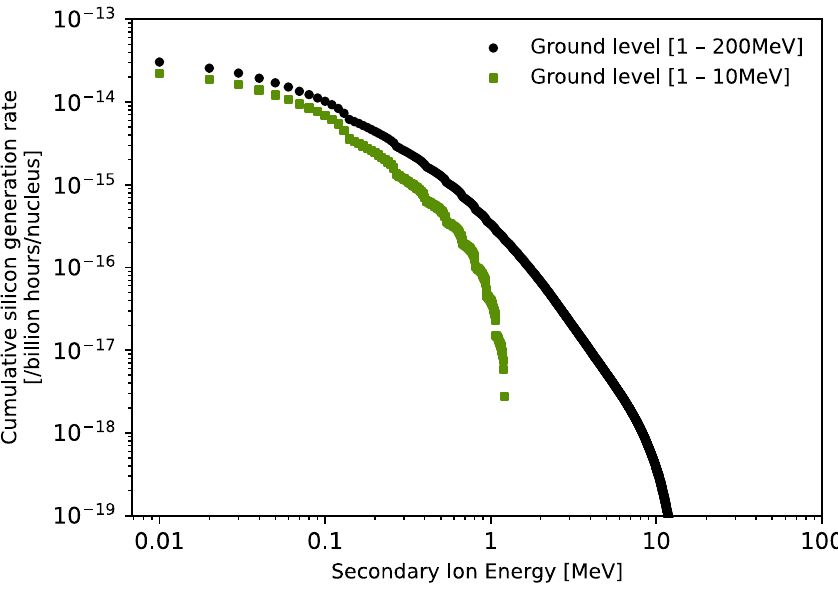
Figure 2. Cumulative distribution of the production rate of silicon at ground level (12 km, 45 degrees of latitude, IEC flux divided by 300) for the neutron energy ranges of 1–10 MeV and 1–200 MeV.